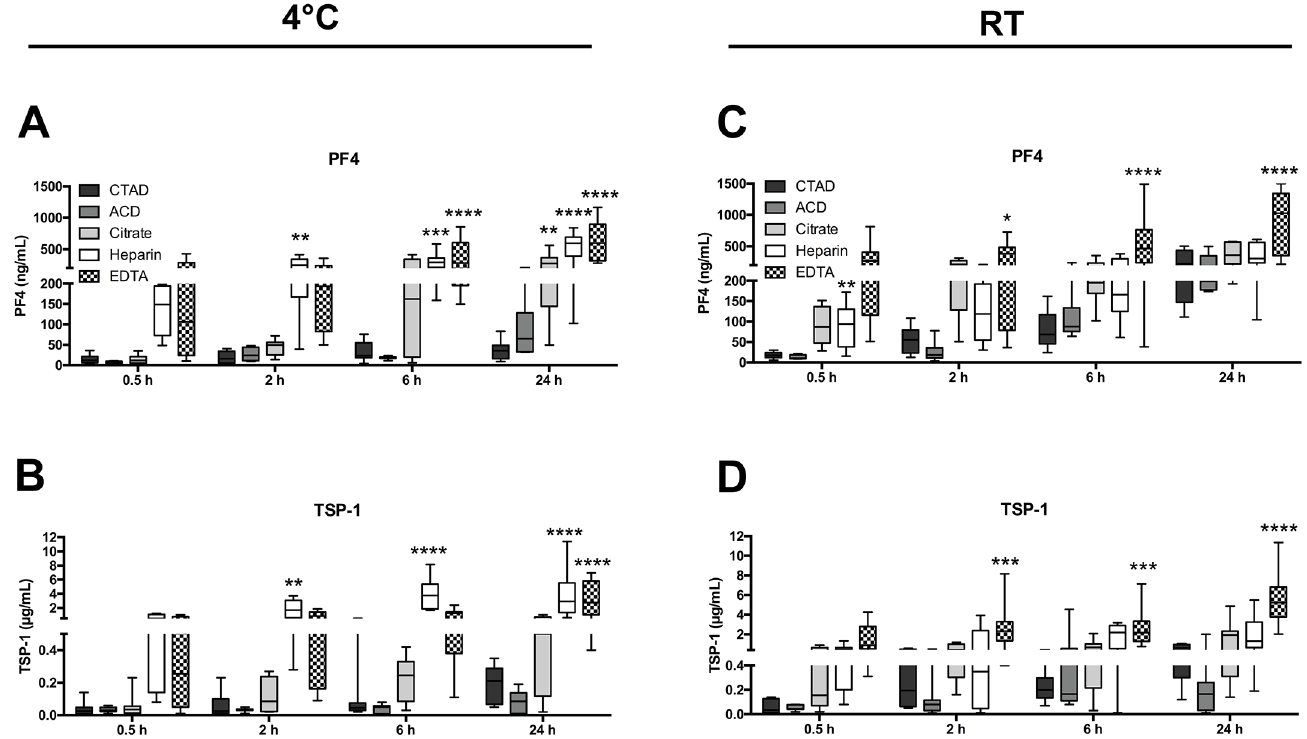
Fig 3. Time-dependent differences in plasma levels of platelet-stored factors. Blood from 8 healthy donorswas anticoagulatedwith CTAD (black bar), ACD (dark grey bar), citrate (grey bar), heparin(white bar) or EDTA (patternedbar) and stored at 4˚C (A-B) or at room temperature (C-D) for 0.5 h, 2 h, 6 h or 24 h until plasma preparation. Concentrations of PF4 (A, C) and TSP-1 (B, D) were determinedfor each time point. Significantdifferences were analyzedusing two-way ANOVA with Dunnett correction (with CTAD as reference)and were depictedas * p < 0.05, ** p < 0.01, *** p < 0.001, and **** p <